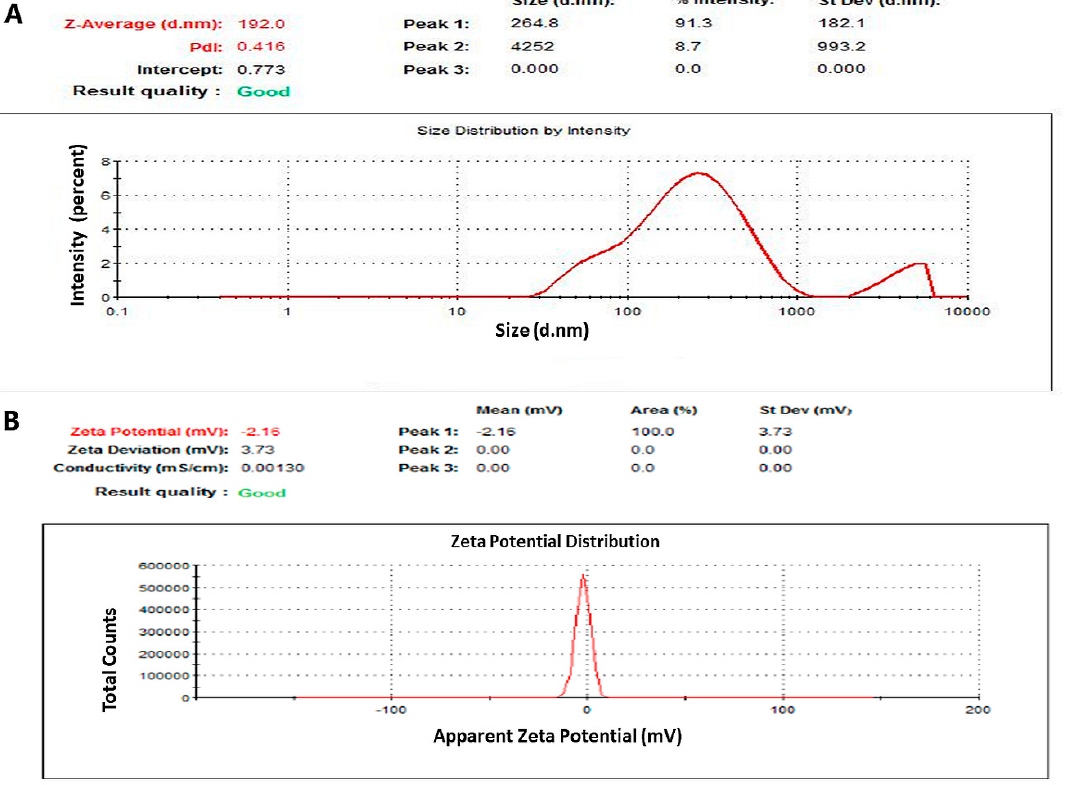
Figure 7. Graphical representation of particle size distribution produced via a DLS technique for determination of ( A ) particle size distribution based on the intensity of PTX-NaCNs and ( B ) zeta potential distribution of PTX-NaCNs.